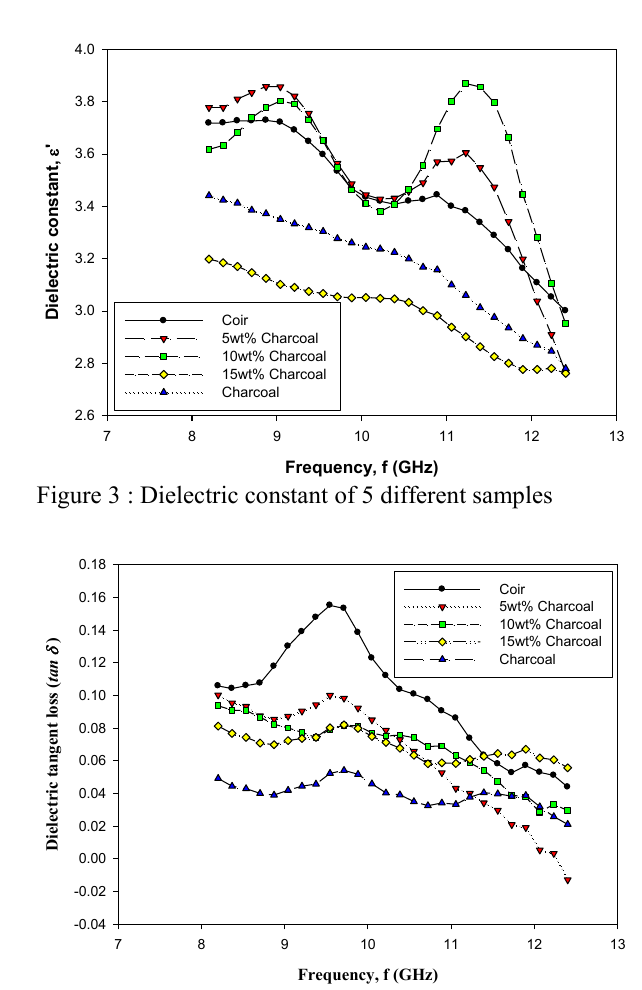
Figure 4: Dielectric tangent loss of 5 different